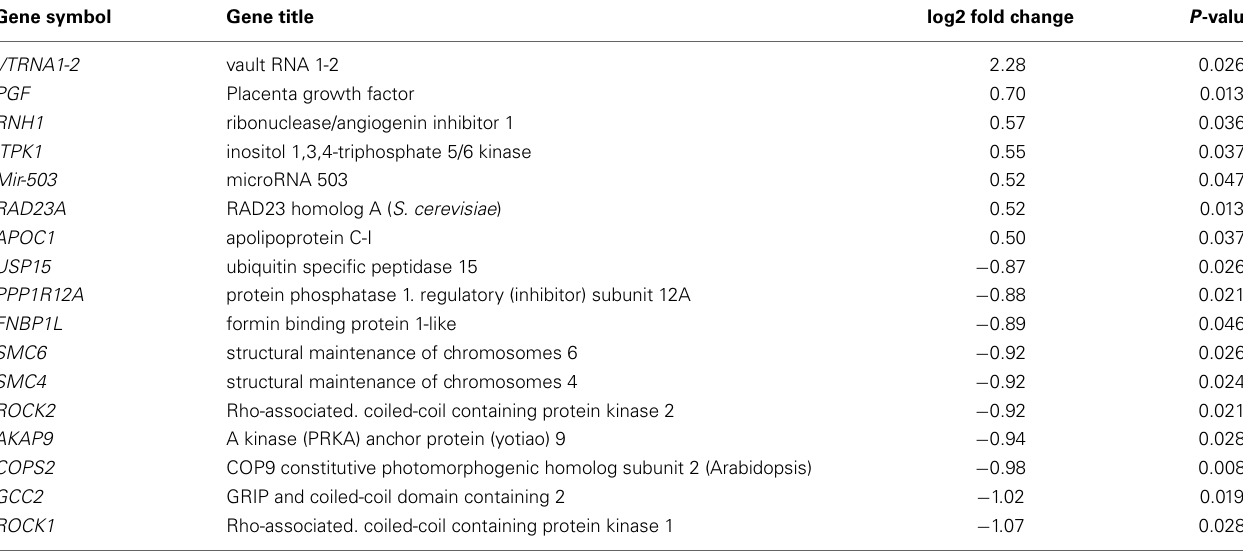
Table 4 | Significantly up- and down-regulated top molecules in the control vs. the depressed group ( − = reduction in expression levels). Gene